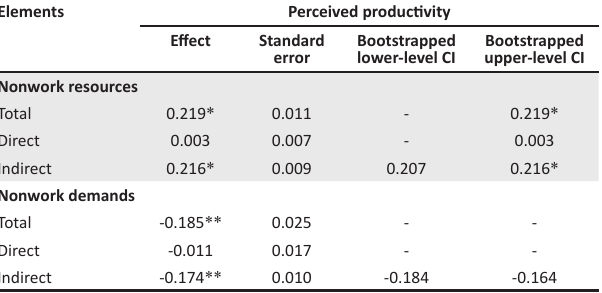
TABLE 2: The mediating effects of work engagement on productivity. Elements